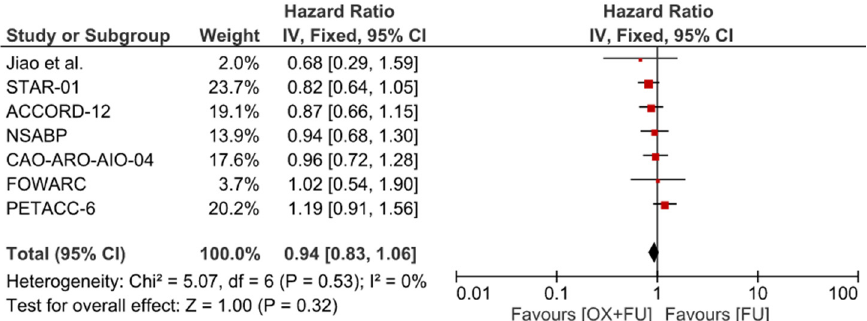
Figure 2. Forest plot of hazard ratio for overall survival.